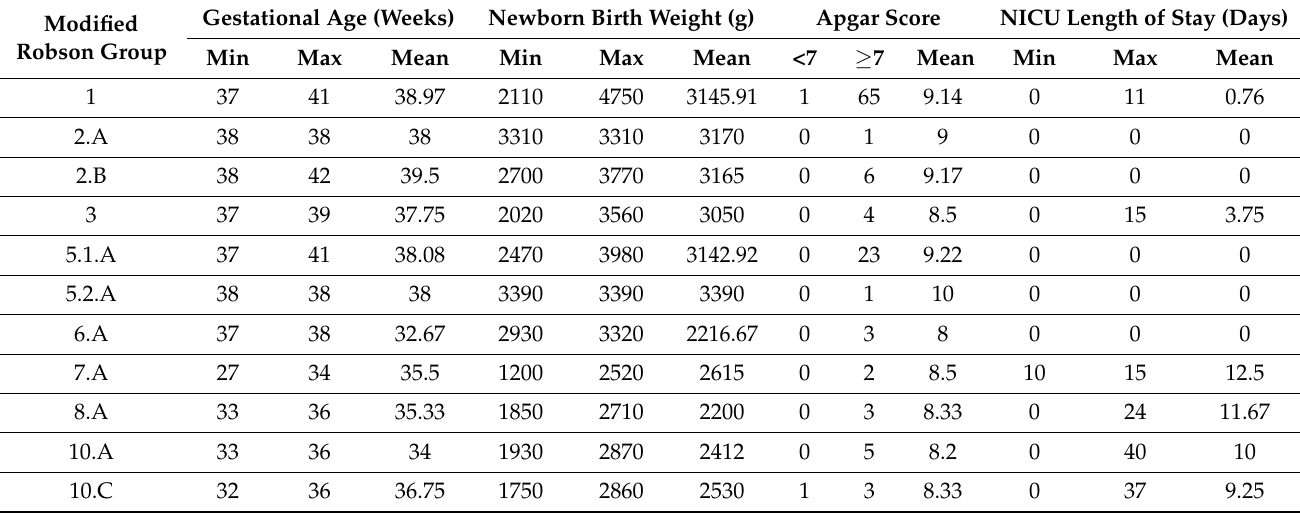
Table 3. Statistical description of newborn outcomes in modified Robson